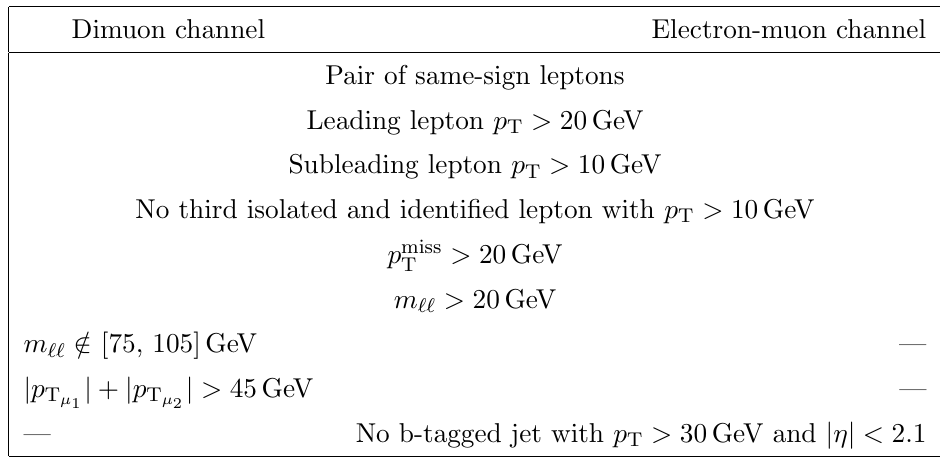
Table 1 . Event selection criteria for same-sign W boson pair production in dimuon and electron- muon